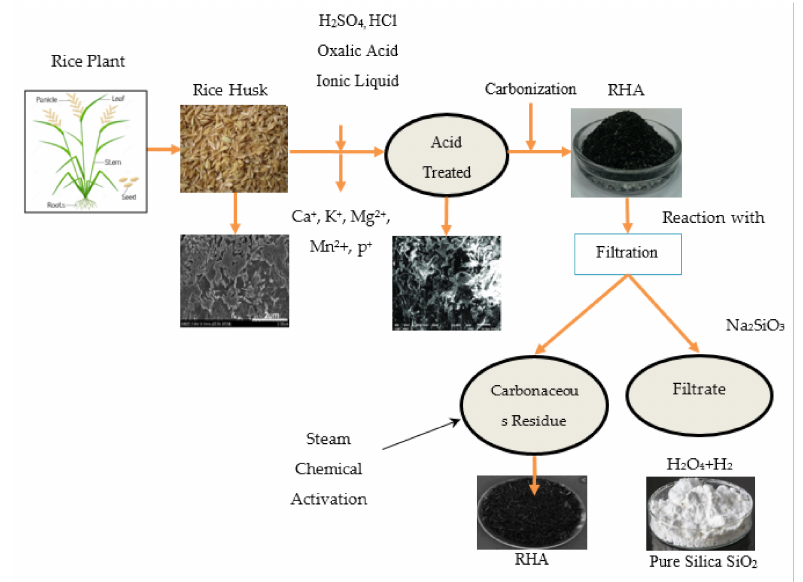
Figure 2. Source of the by-product material and pretreatment of the rice husk (RiH) and rice husk ash